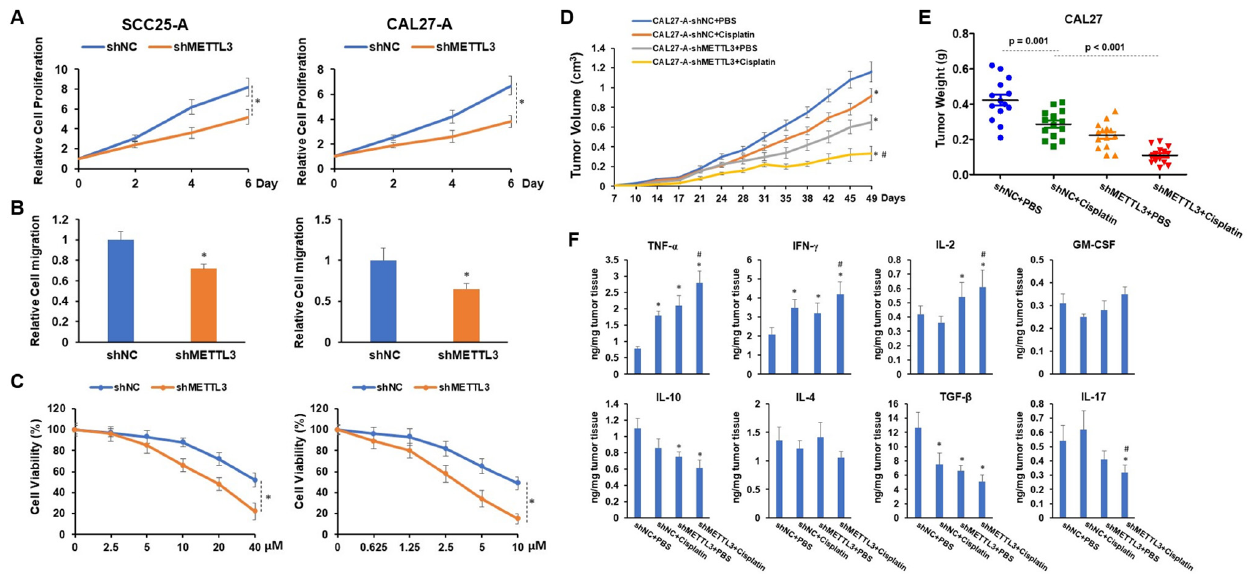
Figure 5. The proliferation, migration, tumor development, and cisplatin resistance of OSCC cells are all decreased when METTL3 is knocked down. Lentiviruses carrying shNC or shMETTL3 were used to infect SCC25-A and CAL27-A cells (referred to as SCC25-A-shNC, SCC25-A-shMETTL3, CAL27-A-shNC, and CAL27-A-shMETTL3). ( A , B ) The cell proliferation ( A ) and migration ( B ) of SCC25-A-shNC, SCC25-A-shMETTL3, CAL27-A-shNC, and CAL27-A-shMETTL3 were tested by CCK-8 assay and transwell migration assay, respectively. ( C ) After being treated with a serial dose of cisplatin for 24 h, the cell viability of these cells was assessed by CCK-8 assay. ( D , F ) BALB/c strain nude mice were implanted with CAL27-A-shNC or CAL27-A-shMETTL3 and treated with cisplatin or PBS twice per week, commencing 10 days after tumor implantation. Beginning at day 7 after tumor implantation, tumor volumes were measured twice a week (D). Tumor weight was taken after all mice were sacrificed ( E ). ( F ) Using ELISA assay, the levels of TNF- α , IFN- γ , IL-2, GM-CSF, IL-10, IL-4, TGF- β , and IL-17 in tumor tissues were determined. * p < 0.05 compared to the control group; # p < 0.05 compared to the cisplatin group.